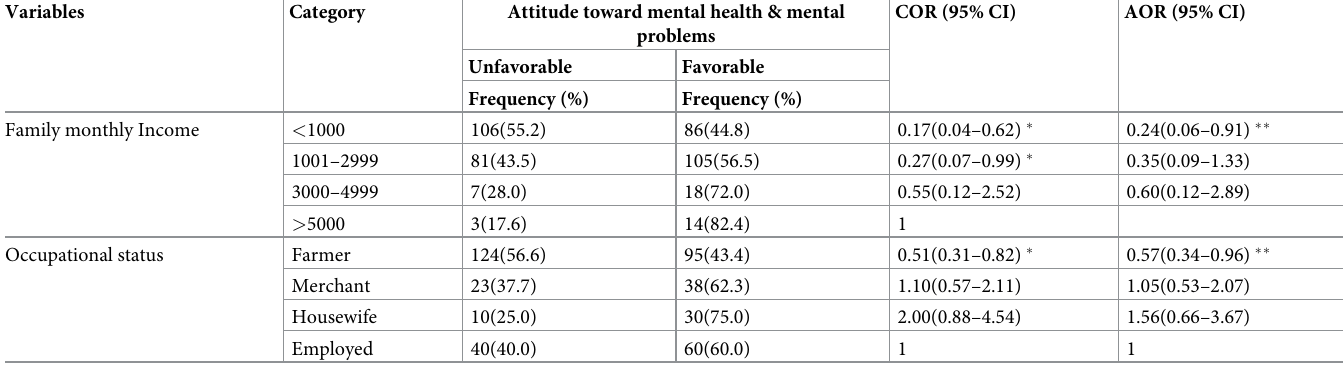
Table 6. Predictors of mental health and mental health problems attitude of the respondents at Jimma Zone, Seka Chekorsa district Oromia, Ethiopia, March 2020.